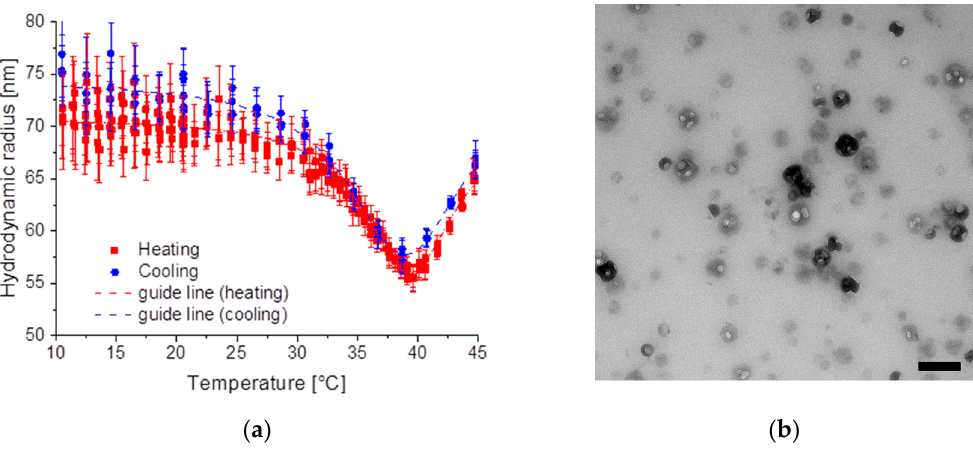
Figure 5. ( a ) Hydrodynamic radius of SiPN-3 as a function of temperature for heating and cooling; ( b ) TEmicrograph of SiPN-3. Scale bar is 200 nm.